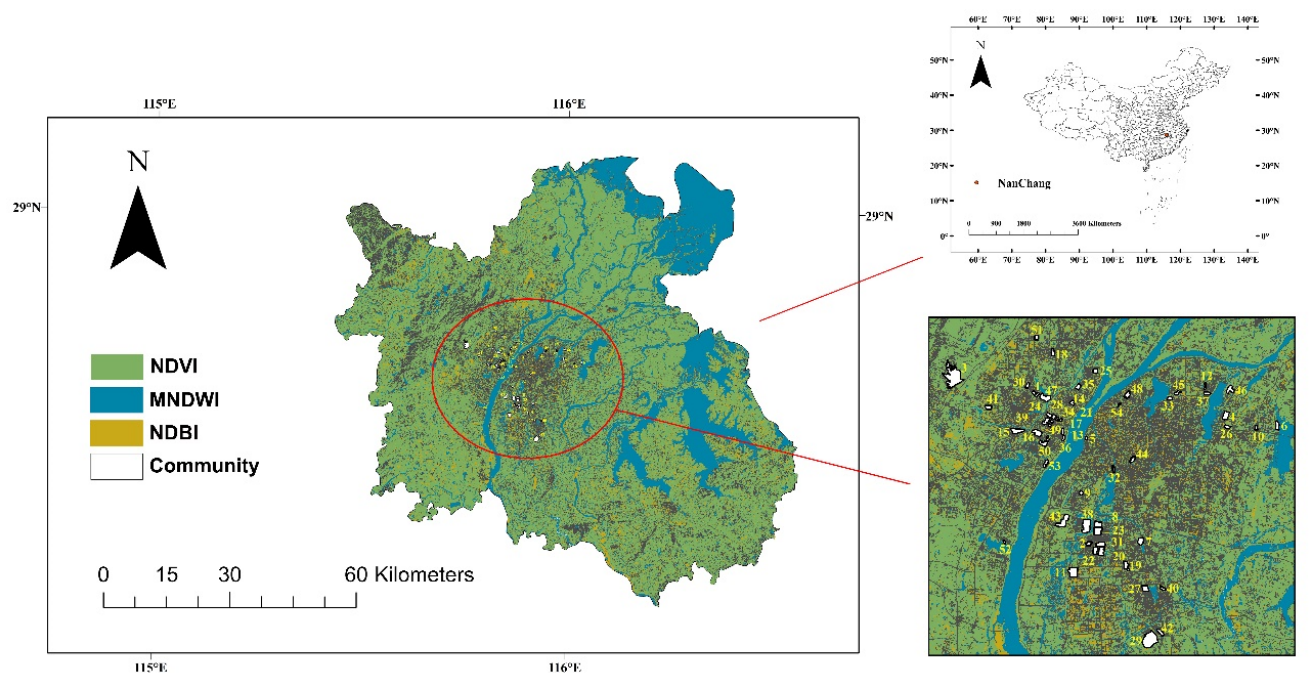
Figure 1. Location of Nanchang city in China with spatial distributions of landscape types and communities. Number of communities refers to order in Table 1. Abbreviations: NDVI, normalized difference vegetation index; MNDWI, modified normalized difference water index; NDBI, normalized difference built-up index.